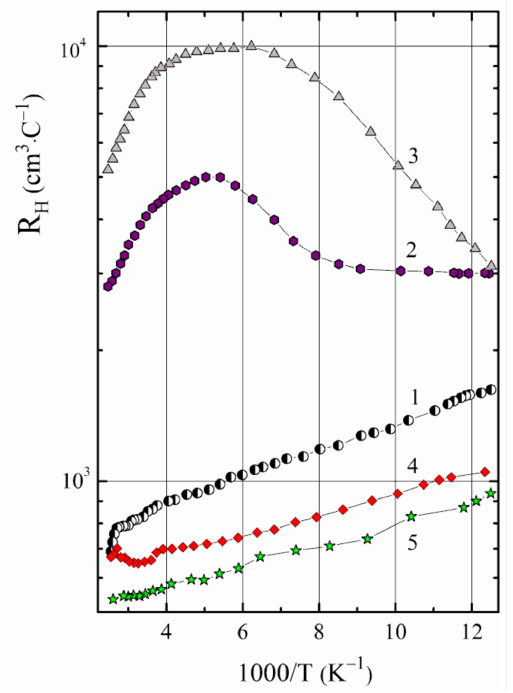
Figure 2. Temperature dependences of the Hall coefficient for the n -InSe samples: pristine (1), first- time and repeatedly intercalated with RbNO 3 (2 and 3, respectively), and annealed in vacuum (4 and 5, respectively).